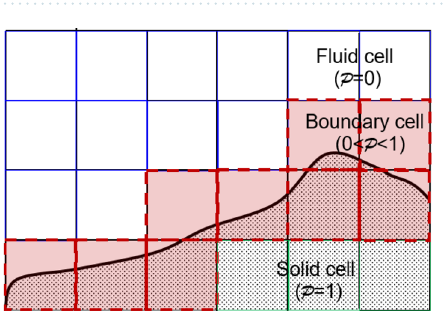
Figure 1. Flowchart from image data to wall stresses. The volumetric parameter and wall normality (green) are the outputs of image processing (blue) and inputs of CFD using VLBM (yellow), enabling seamless connection between both.